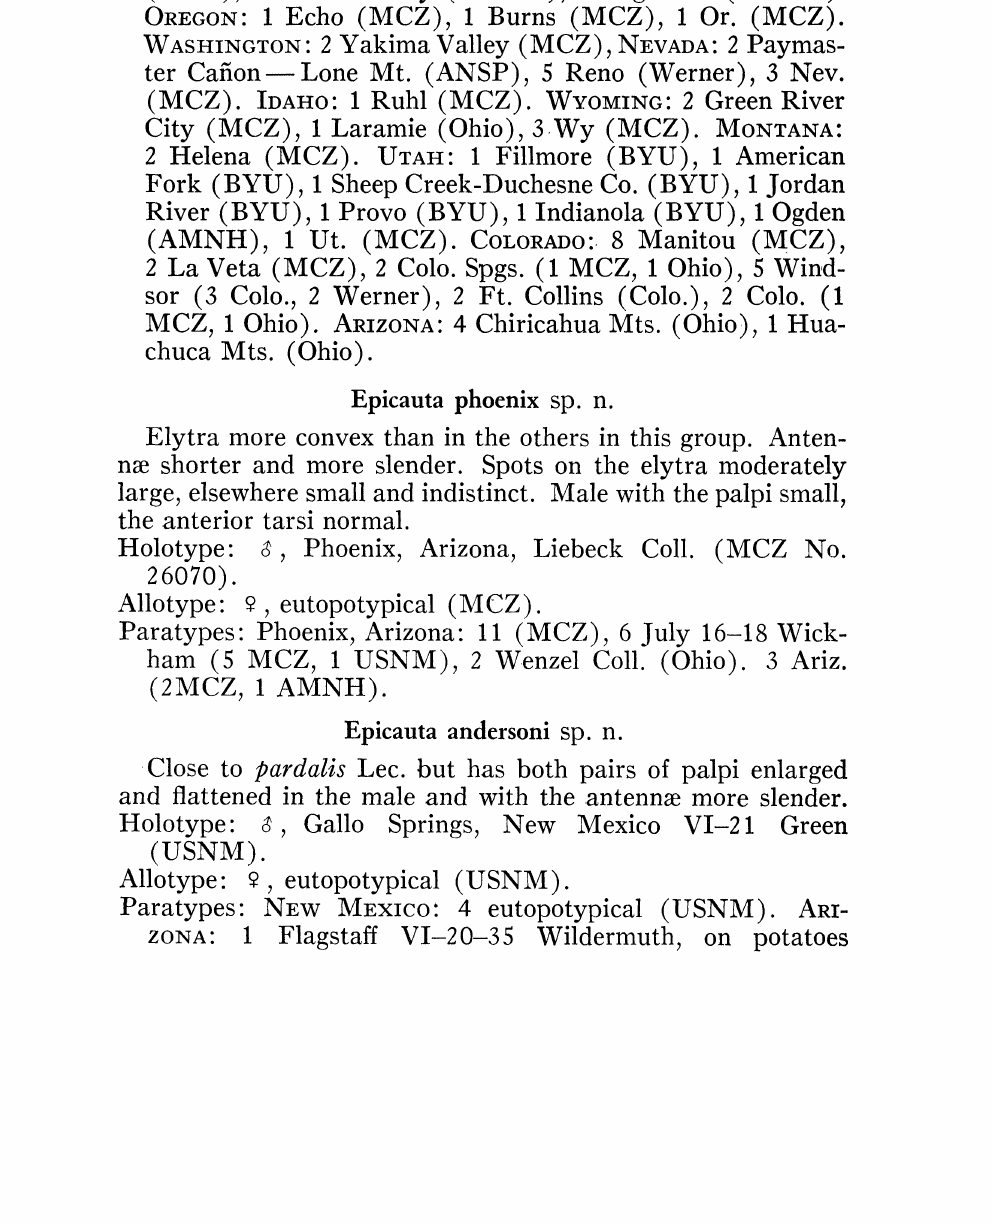
First segment of male anterior tarsi narrow, slightly outcurved, with the pad absent from at least the basal